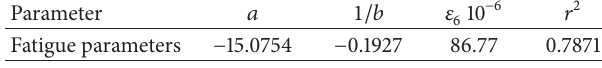
Table 1: Values of fatigue parameters for mix AC 11.